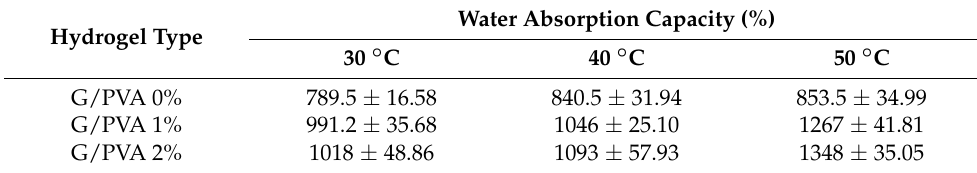
Table 5. The water absorption capacity (WA) of gelatin and gelatin/PVA hydrogels was determined after 24 h of incubation at different temperatures.